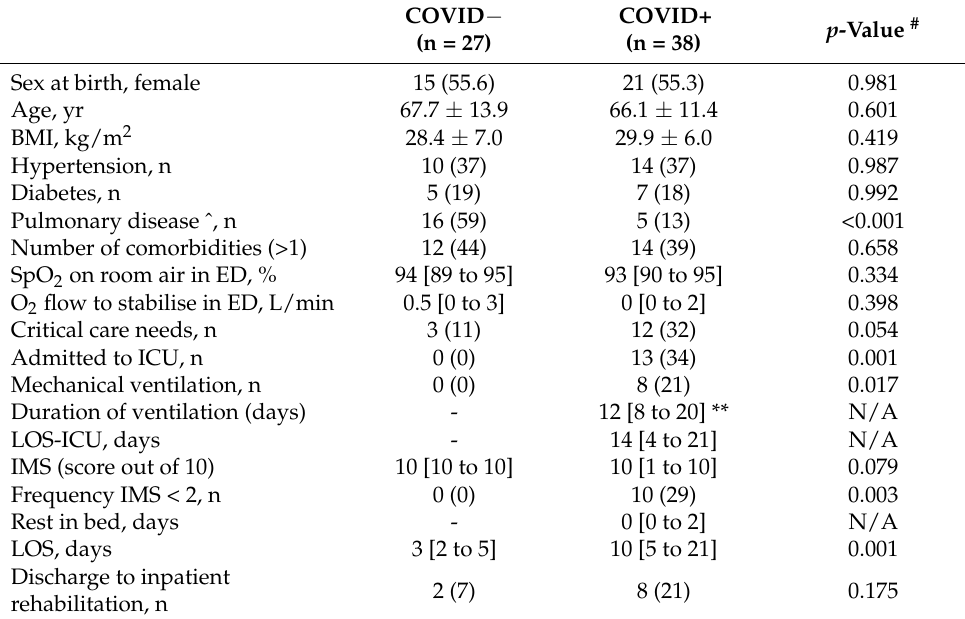
Table 1. Characteristics * of the participants grouped according to COVID-19 PCR